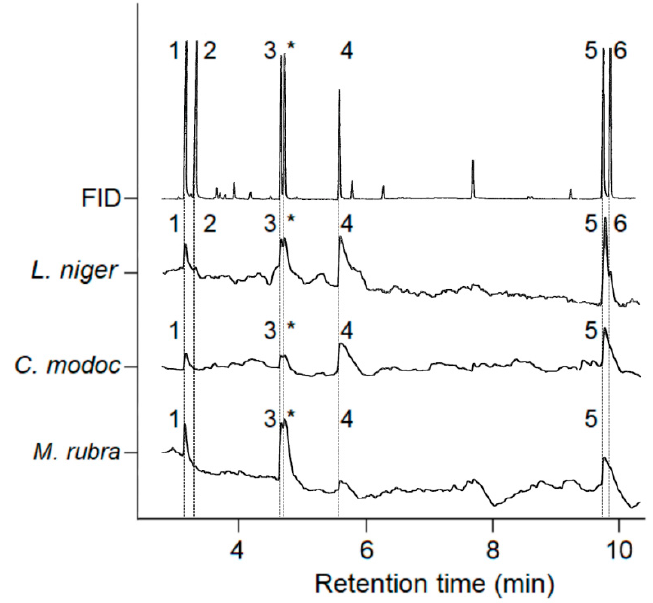
Figure 2. Representative recordings (n = 3 each) of the responses of a gas chromatographic flame ionization detector (FID) and an electroantennographic detector (EAD: Antenna of a Lasius niger , Camponotus modoc , or Myrmica rubra worker ant) to pheromone components present in the six-trail pheromone blend (see Table 1). Numbers in the FID trace refer to the following pheromone components: (1) 2,5-dimethylpyrazine; (2) 4-methyl-3-heptanone; (3) 3-ethyl-2,5-dimethylpyrazine; * = 3-ethyl-2,6-dimethyl pyrazine (non-natural isomer present in synthetic source); (4) (2 S ,4 R ,5 S )-2,4-dimethyl-5-hexanolide; (5) 3,4-dihydro-8-hydroxy-3,5,7-trimethylisocoumarin; and (6) ( Z )-9- hexadecanal. Table 2. List of trail pheromone components produced by sympatric ant species inhabiting ant communities in the Pacific Northwest (Western carpenter ants, Camponotus modoc ; black garden ants, Lasius niger ; European fire ants, Myrmica rubra ) and by allopatric ant species (pavement ants, Tetramorium caespitum ; desert harvester ants, Novomessor albisetosus ; Argentine ants, Linepithema humilis ), as well as information as to whether community members ( La. niger , Ca. modoc, and M . rubra ) antennally respond to these components in electrophysiological recordings (summary of gas chromatographic-electroantennographic detection (GC-EAD) results; see Figure 2).